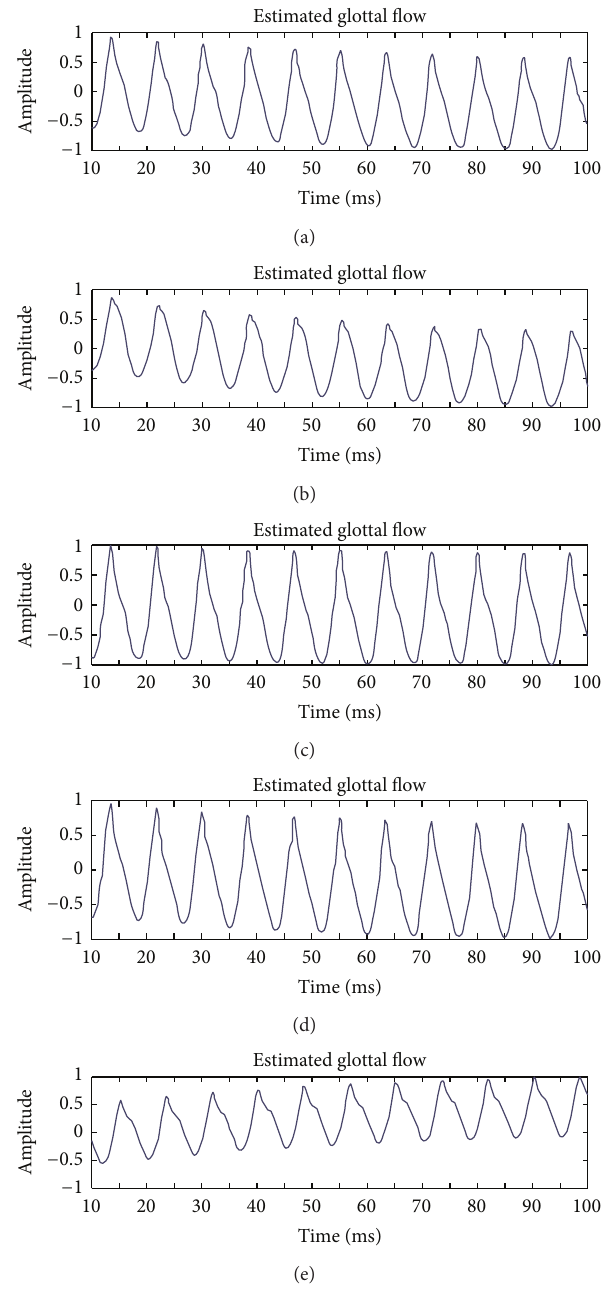
Figure 9: Glottal pulses for five vowels /a/, /e/, /i/, /o/, and /u/, respectively.